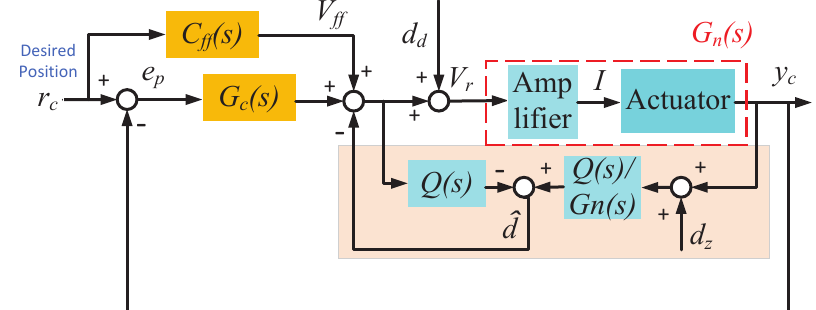
Figure 13. Control system